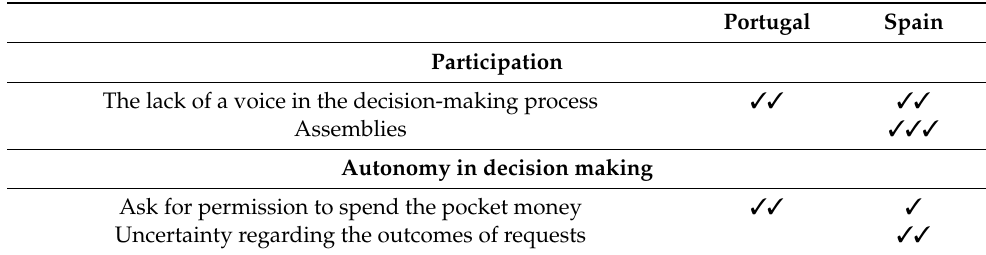
Table 5. Description of subcategories about participation and autonomy by countries.